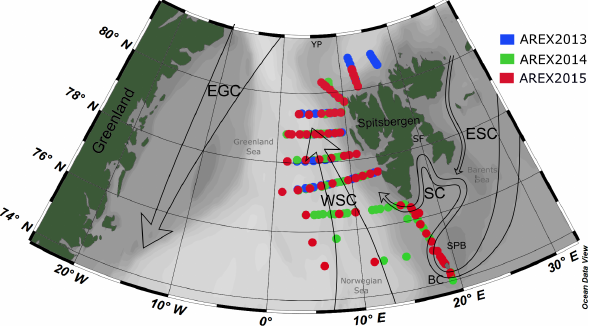
Figure 1. Map of the sampling stations during AREX2013 (blue circles), AREX2014 (green circles), and AREX2015 (red circles) with general surface circulation patterns in the Nordic Seas.